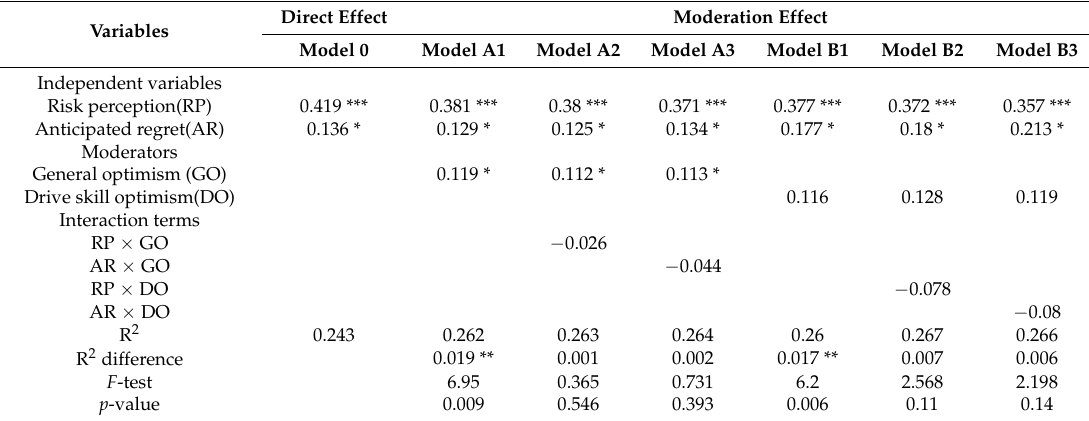
Table 4. The results of moderator